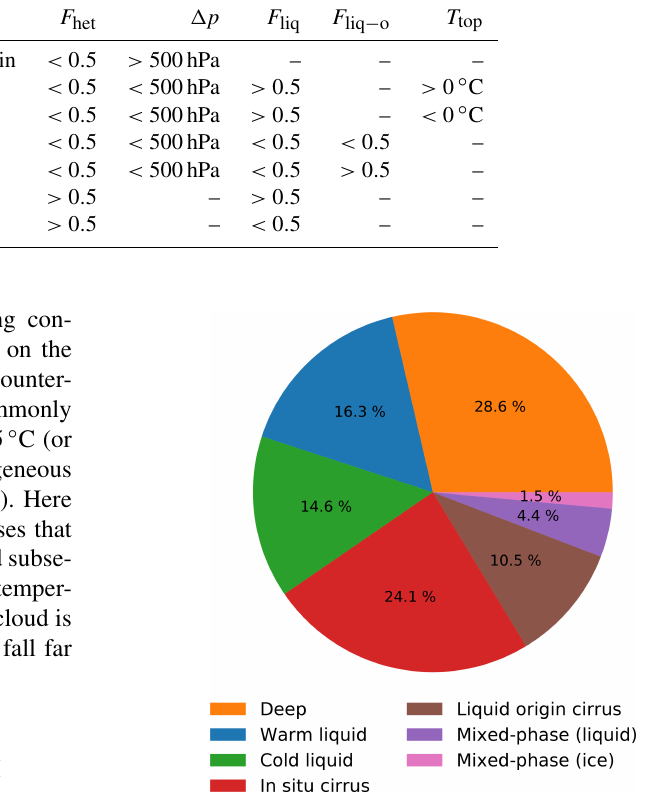
Figure 11. Global relative contribution to the 3-D cloud volume (as measured by the air mass occupied) for the cloud types defined in Table 4 based on their formation pathways. Data are sampled every time step for 10 years of simulation with the new model